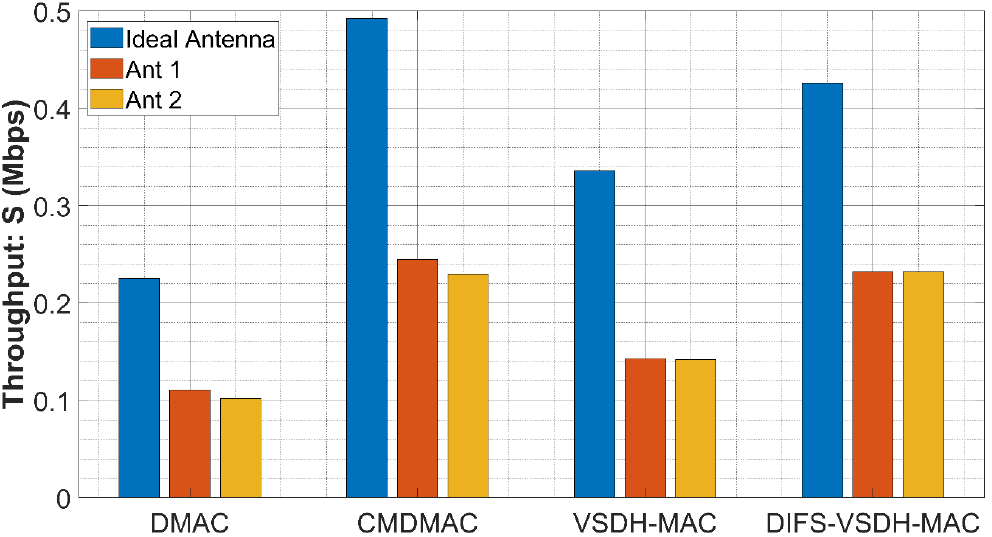
Figure 7. Impact of antenna pattern on throughput performance with 𝑀 = 4 .